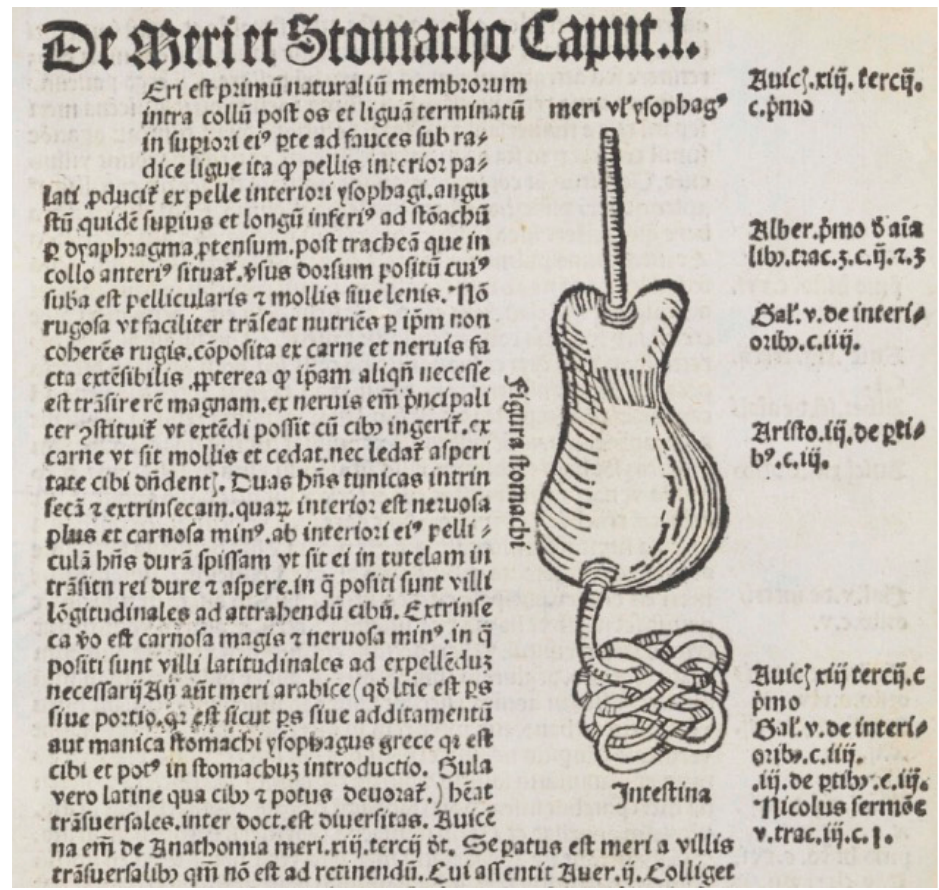
Figure 1. Hundt’s illustration of the stomach and intestines (Hundt 1501, fol. O V r ).